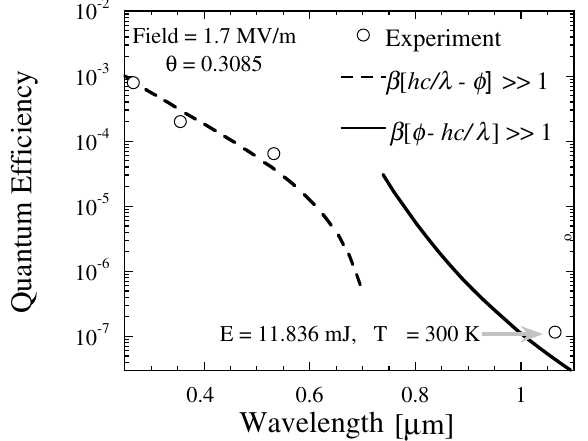
FIG. 13. Measured quantum efficiencies compared to the asymptotic formulas of Eq. (18). Dot indicated by arrow cor- responds to the black dot in Fig.